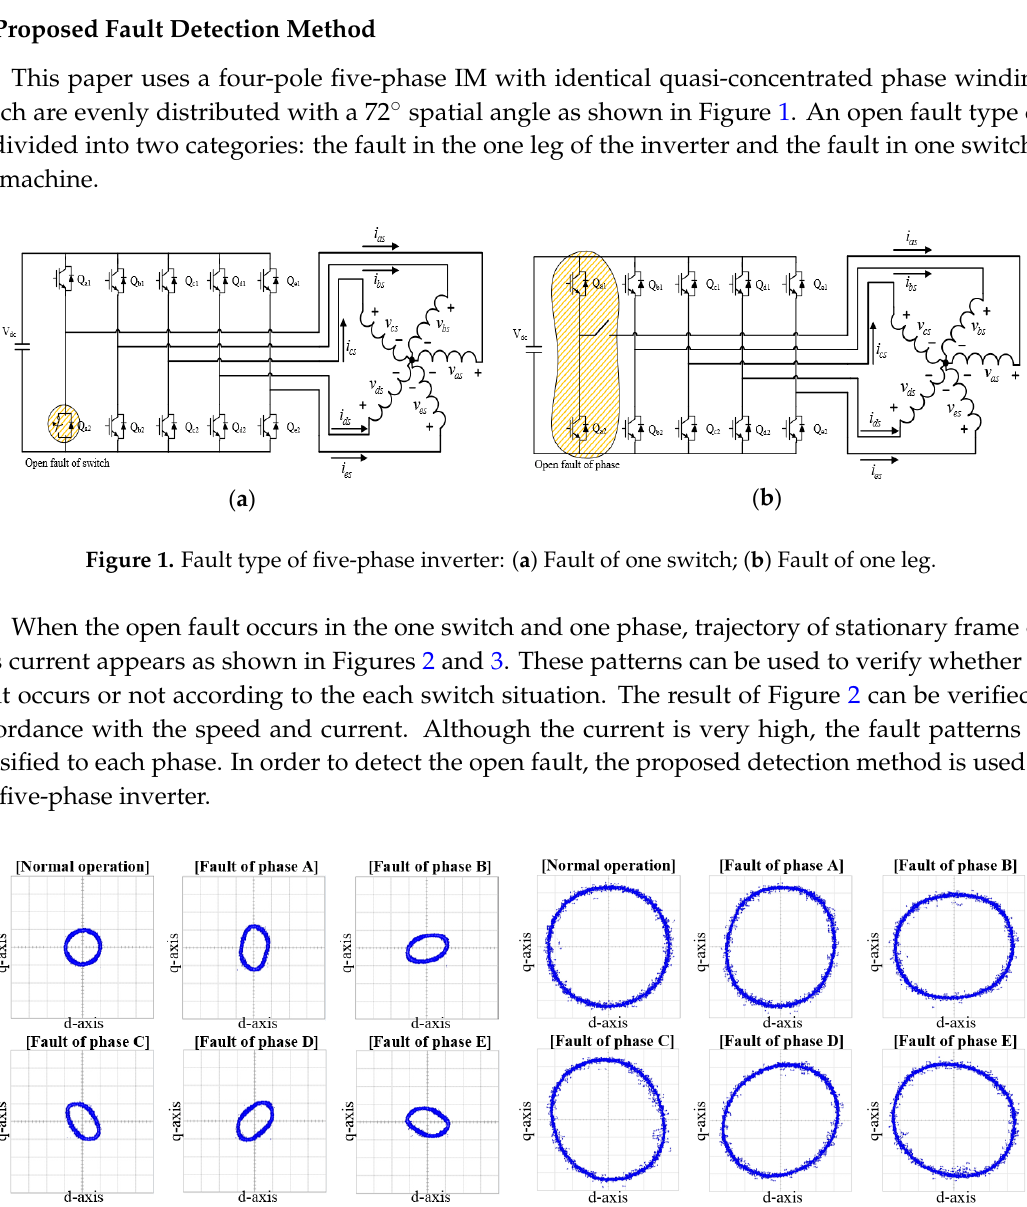
Figure 2. Trajectory of stationary d 1 ‐ q 1 axis current for open fault of each phase: ( a ) at 300 rpm and 1 A; ( b ) at 1000 rpm and 3.5 A.